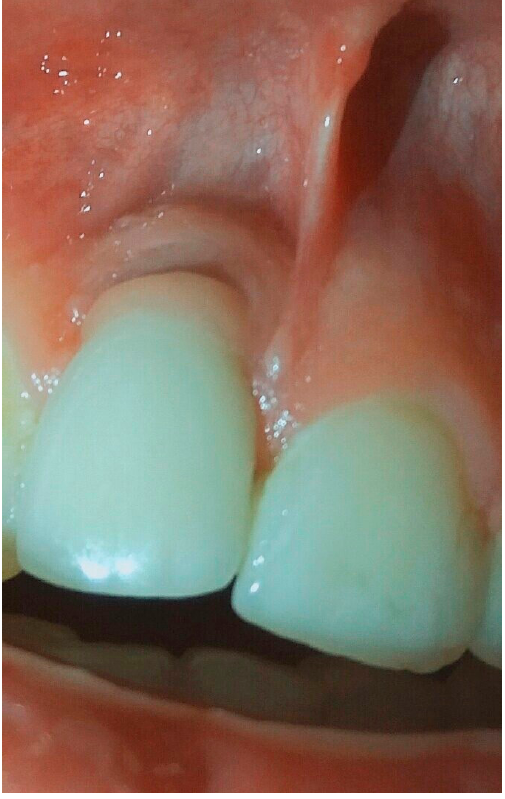
Figure 8. Condition of soft tissue near dental implant in 1.1 position after treatment in 6 months.